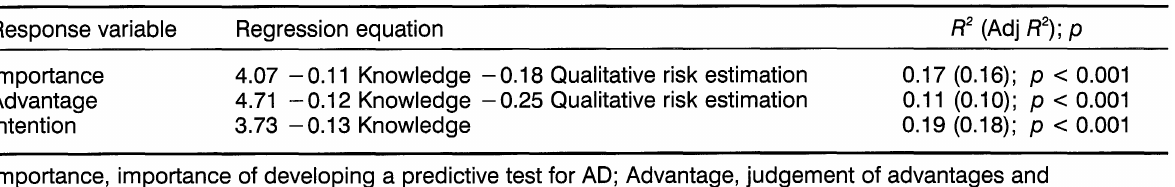
TABLE V. Regression analyses with the attitudinal variables as response variables Response